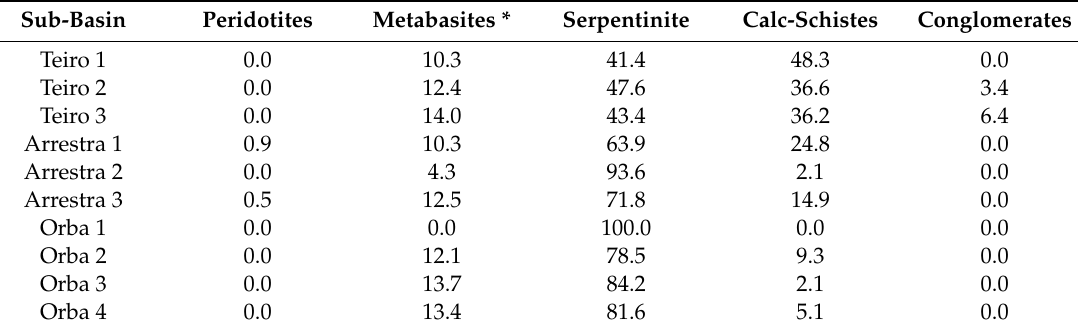
Table 2. Relative abundance (surface area %) of the rock types outcropping in the ten sub-basins considered in this work, grouped starting from the map of Figure